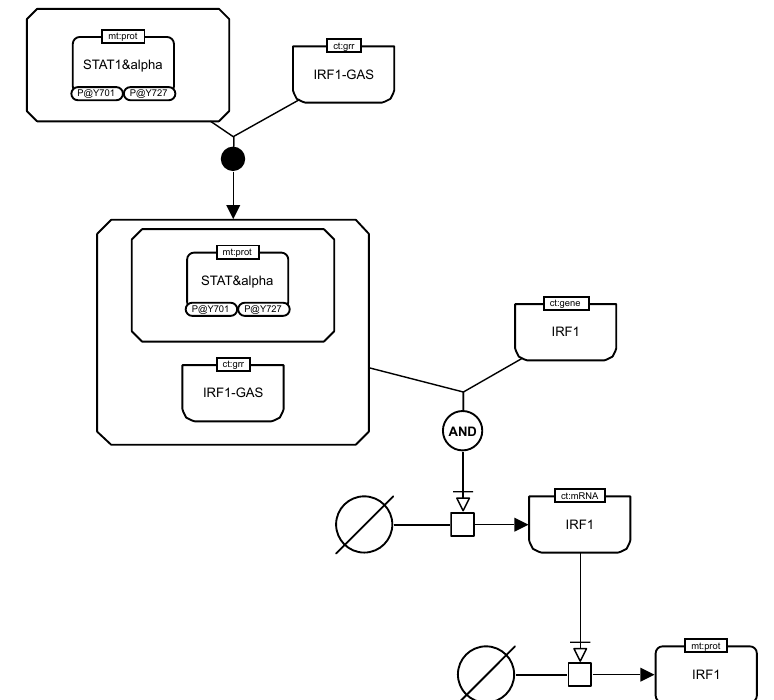
Figure A.5: Activated STAT1 α induction of the IRF1 gene. An example of gene regulation using logical